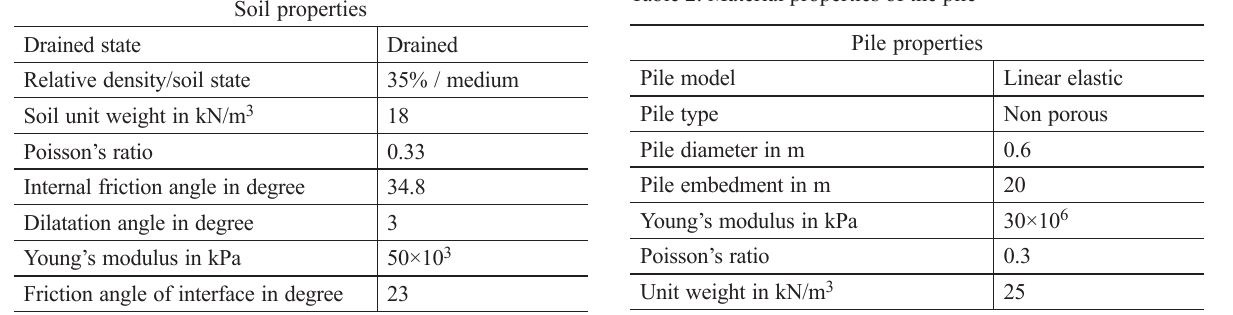
Table 2. Material properties of the pile